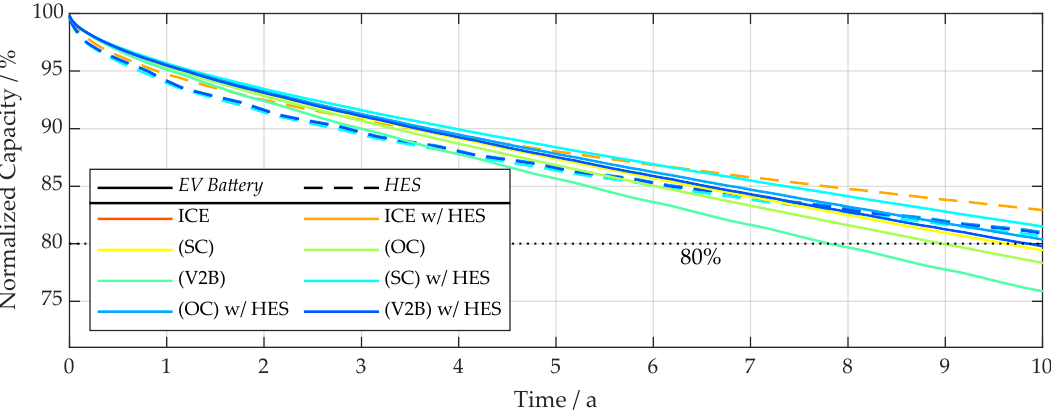
Figure 8. Remaining capacity of electric vehicle’s battery (nickel manganese cobalt (NMC) cell chemistry, solid line) and home energy storage system (HES) (lithium iron phosphate (LFP) cell chemistry, dashed line) over ten years, with the highlighted end of life (EOL) threshold at 80% nominal battery capacity.